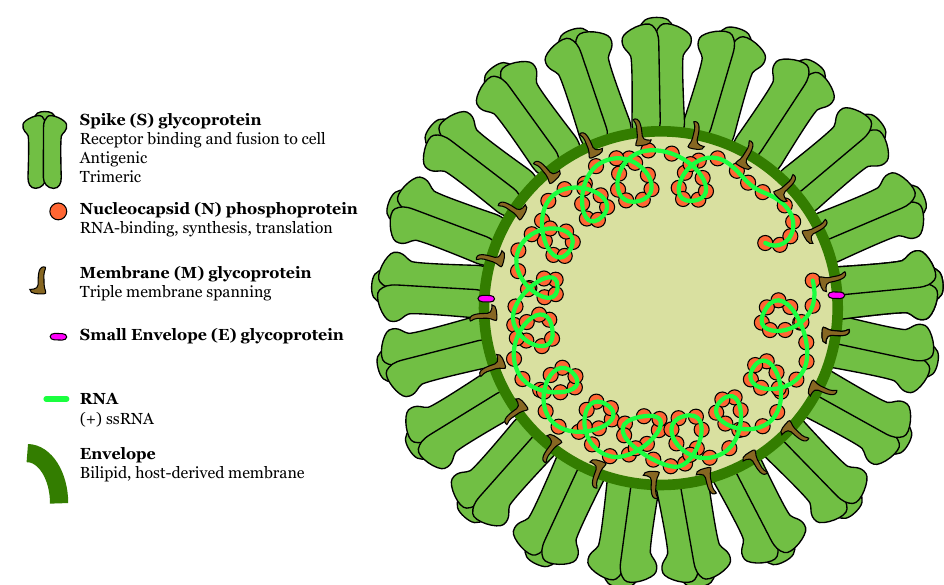
Figure 1. Schematic of a predicted MERS-CoV virion. Along with membrane and envelope transmembrane proteins, the spike glycoprotein protrudes from a host cell-derived lipid bilayer, giving the virion a distinctive appearance. Positive-sense viral RNA is associated with nucleocapsid phosphoprotein in a helical structure.